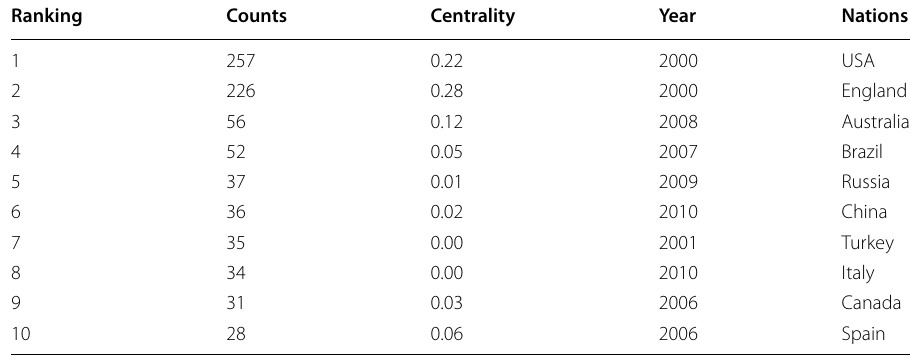
Table 3 Top 10 productive countries of “fashion design” articles